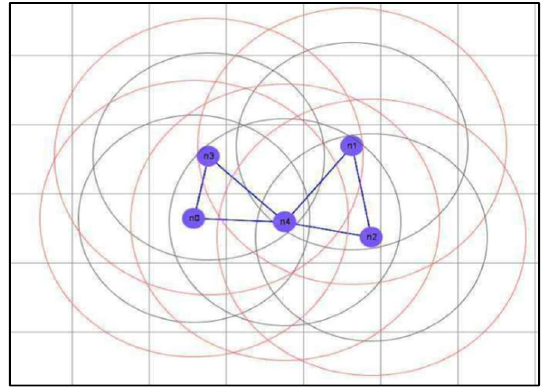
Figure 1. Topology of mobile ad hoc networks with marked transmission and interference band Table 1. The concept of ad hoc networks according to standardization bodies Each node can communicate directly with other nodes, IEEE IETF which are in the common transmission range. To Ad hoc networks Mobile ad hoc networks communicate with nodes that are outside this range, the (MANET) node should use proxy nodes to transmit jump-by-jump messages.